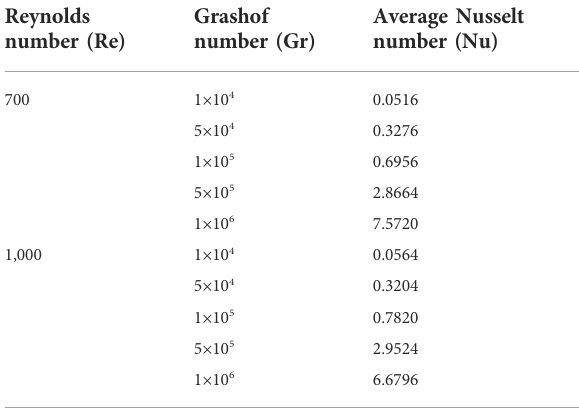
TABLE 2 Computation of Nusselt number for different Grashof numbers and Reynolds numbers. Reynolds number